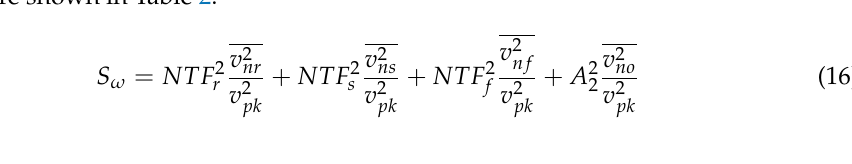
Table 2. The performance of partial vacuum description of system noise.